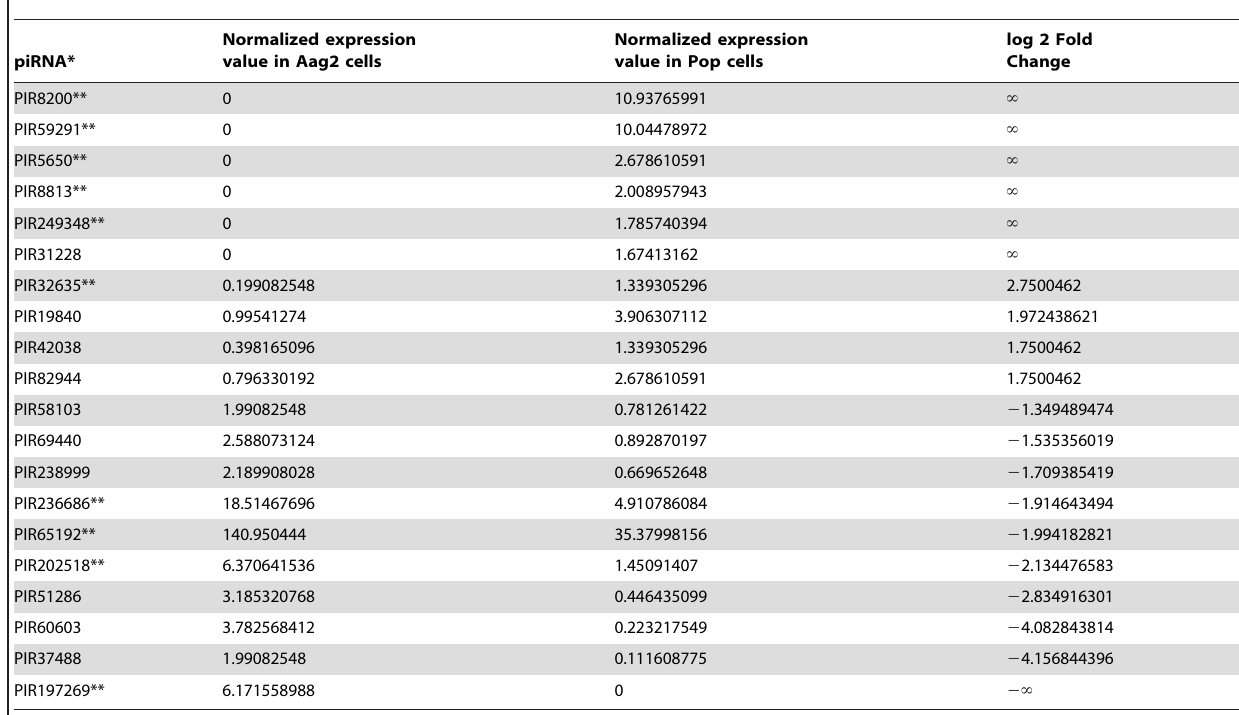
Table 4. Differentially expressed piRNAs in the cytoplasm of Aag2 cells versus Wolbachia -infected cells (Pop).